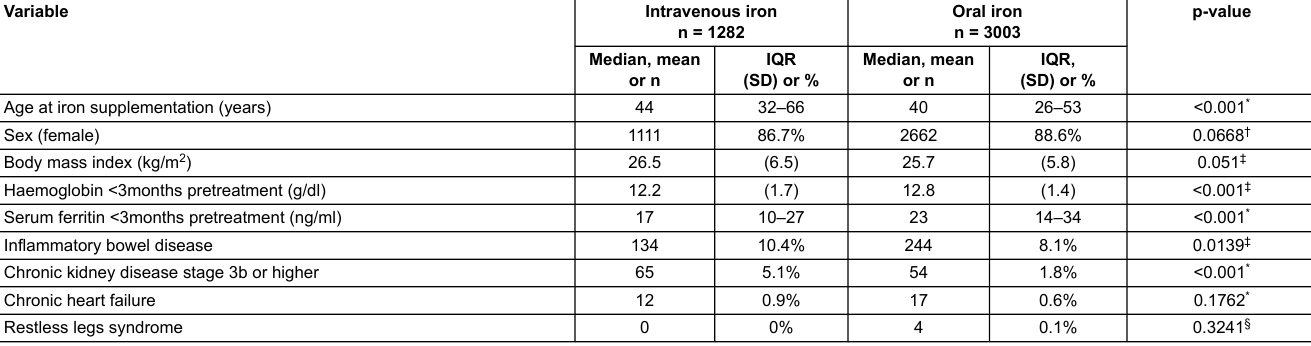
Table 1: Description of cases (total n = 4285). Variable